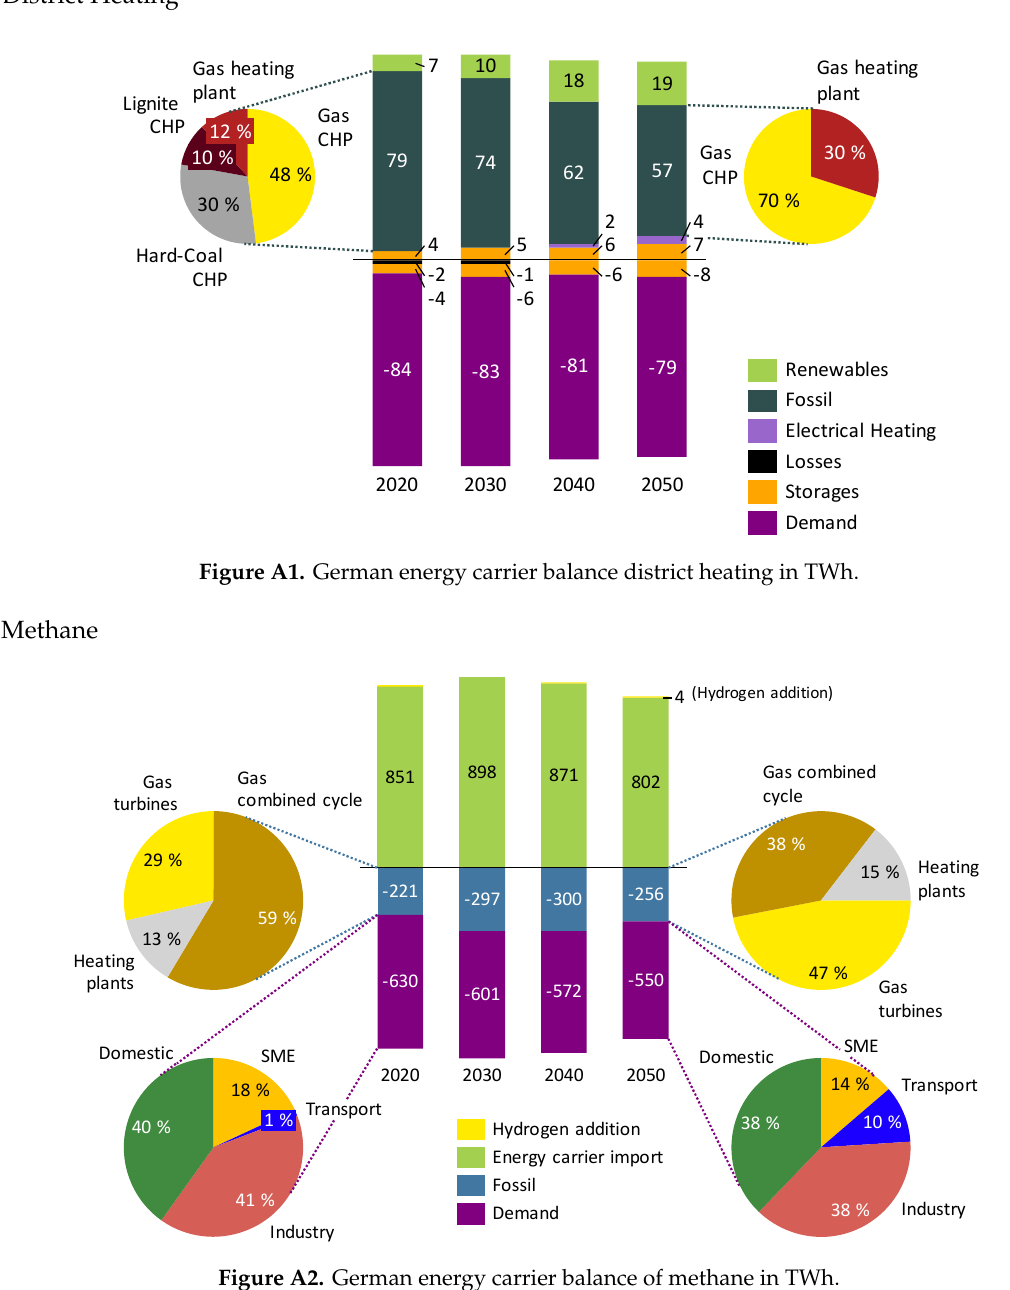
Figure A2. German energy carrier balance of methane in TWh.